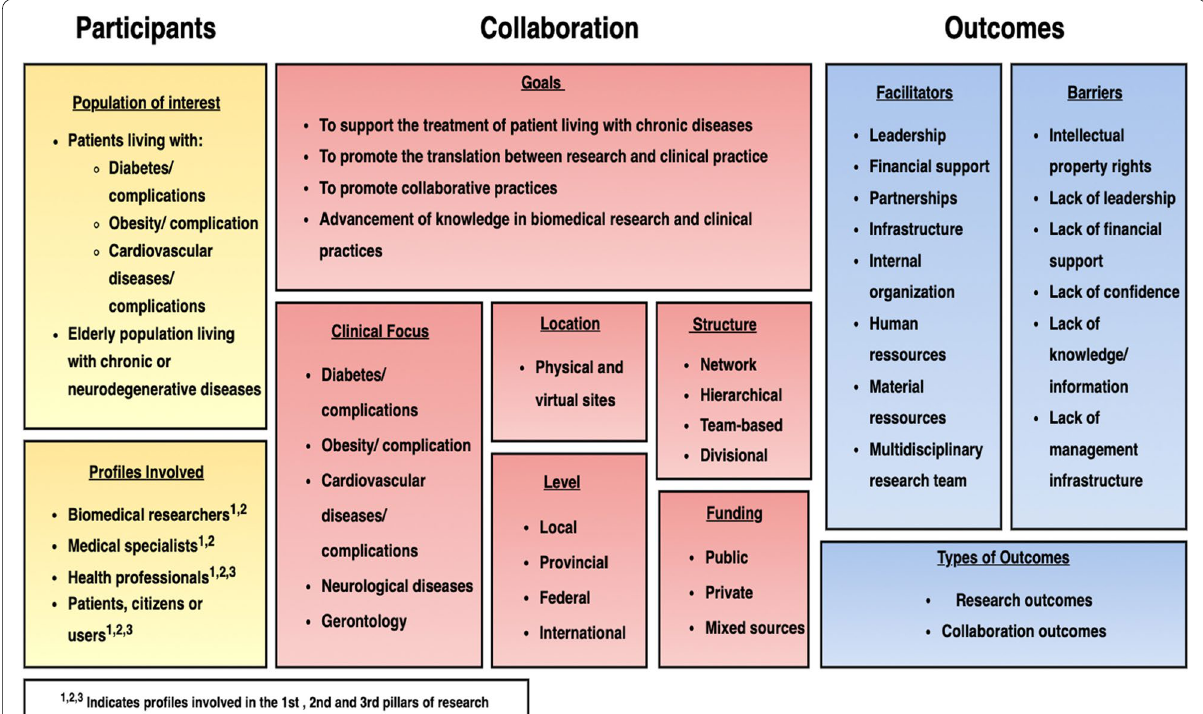
Fig. 4 Characteristics of collaboration models for translational research on chronic diseases. Note: This figure visually summarizes the findings of this scoping review with the characteristics of the collaborations described in the selected articles. Summarizes the characteristics of the participants (yellow), collaboration (red) and of the outcomes (blue) described in the selected